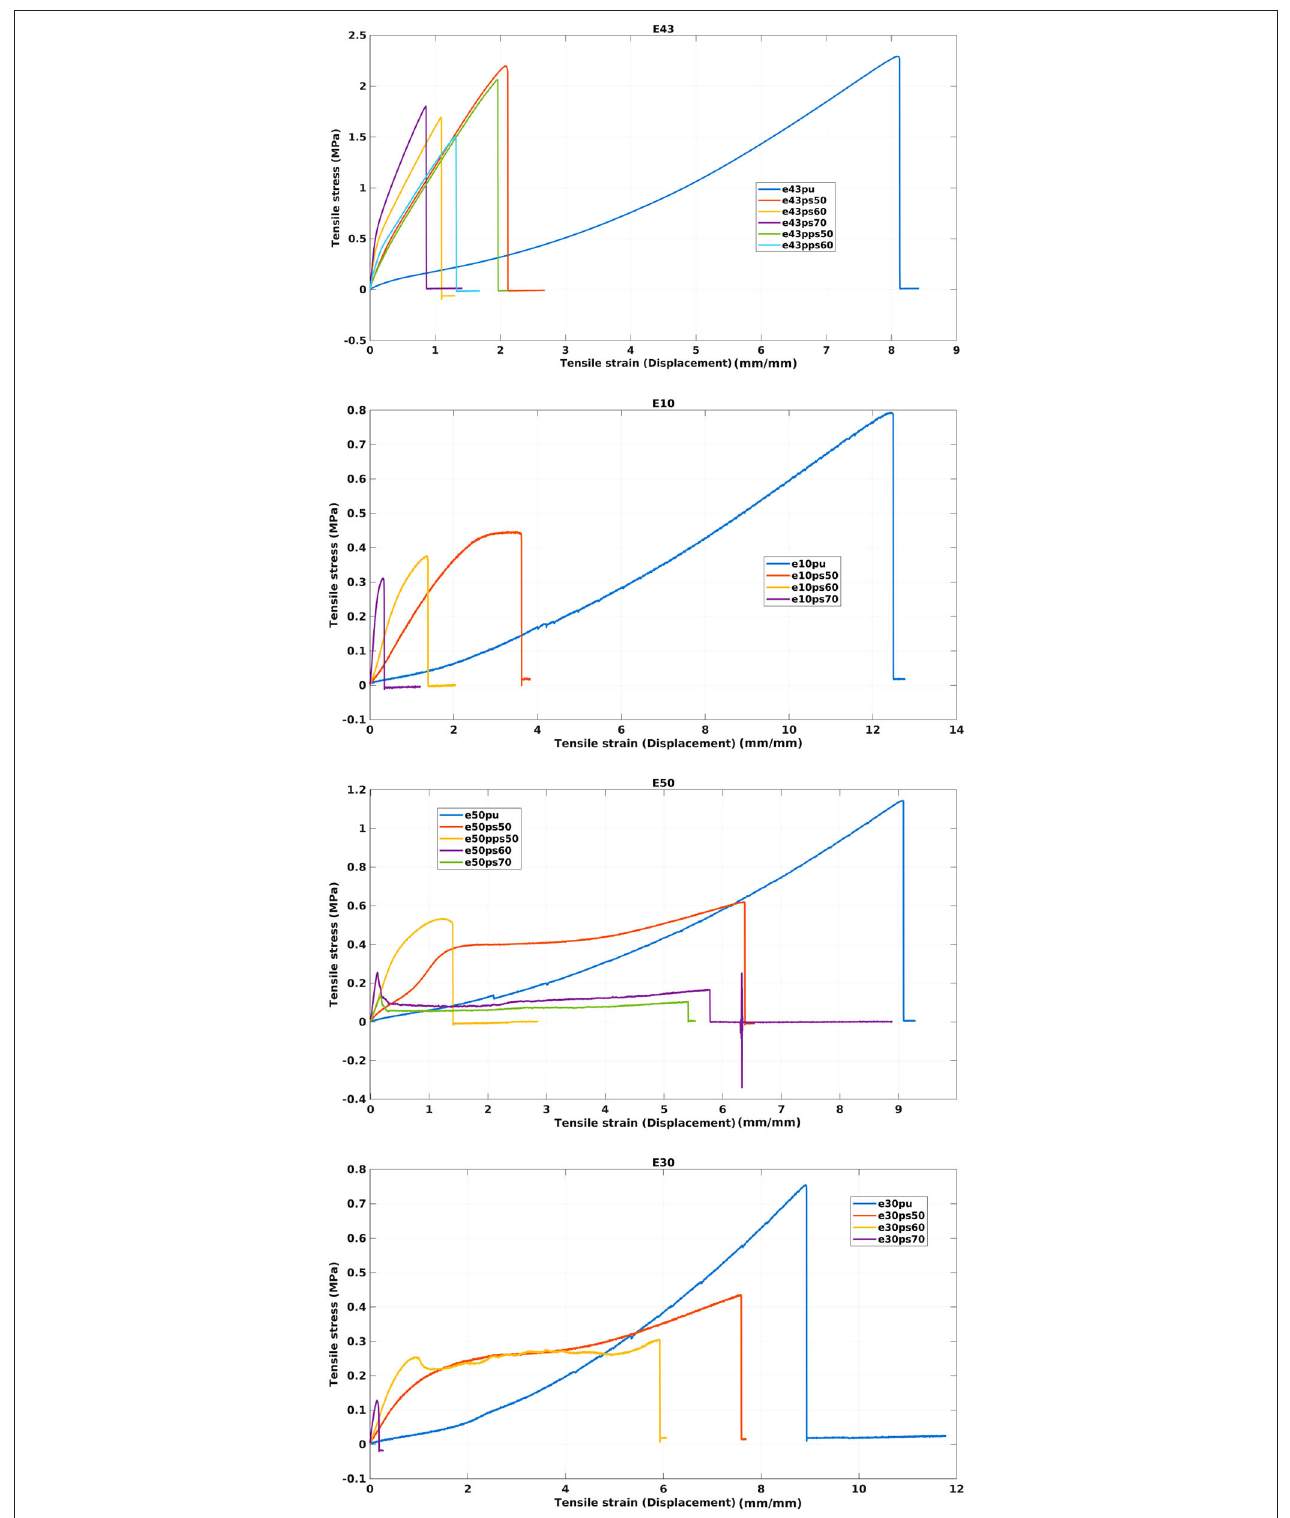
FIGURE 5 | Stress-strain curves of the specimen in bold in Table 1 . Ecoflex TM 00-30 and Ecoflex TM 00-50, 50% blends maintain most of tensile strain resistance of the pure elastomers.